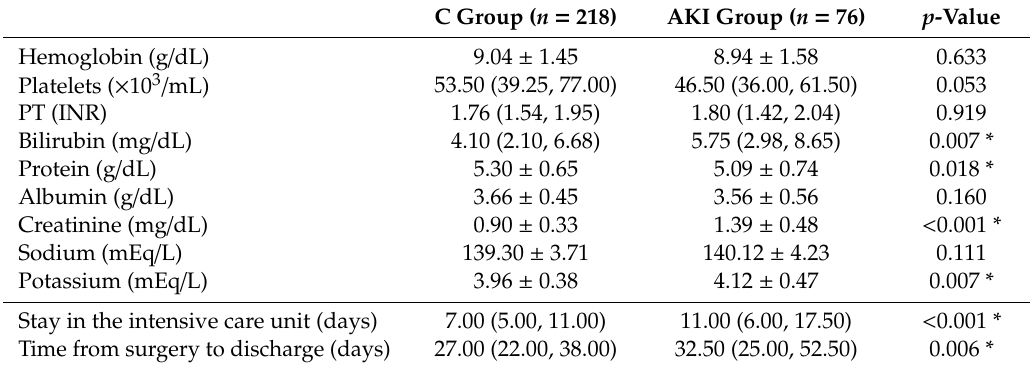
Table 4. Postoperative data of patients who underwent liver